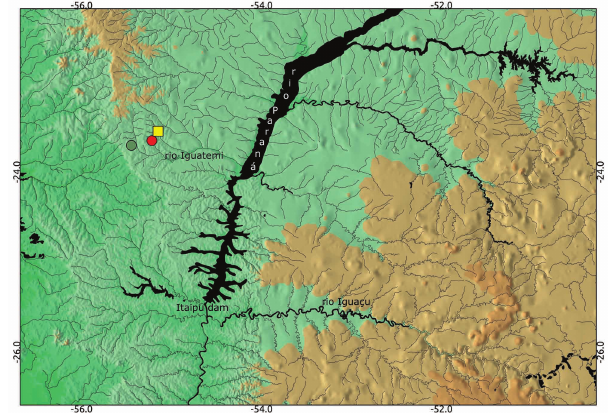
Fig. 4. Phallotorynus pankalos distribution, córrego Sossego (square, type-locality), córrego Mirim (red dot) and córrego Piraí (green dot).